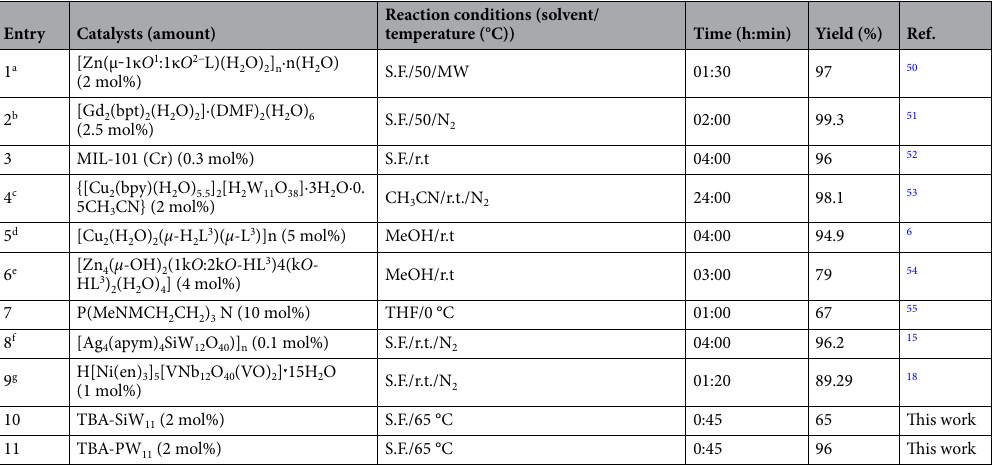
Table 3. A comparison of catalytic activity of different reported coordination polymers in the CYSR of BA with TMSCN. Reaction conditions: A mixture of BA, TMSCN, and catalyst in solvents at different temperatures. a L: 5 ‐ {(pyren ‐ 4 ‐ ylmethyl)amino}isophthalate. b bpt: biphenyl-3,4 ′ ,5-tricarboxylate. c bpy: bipyridine. d H 3 L 3 : 2-(2-(4,4-dimethyl-2,6-dioxocyclohexylidene)hydrazinyl)terephthalic acid. e HL 3